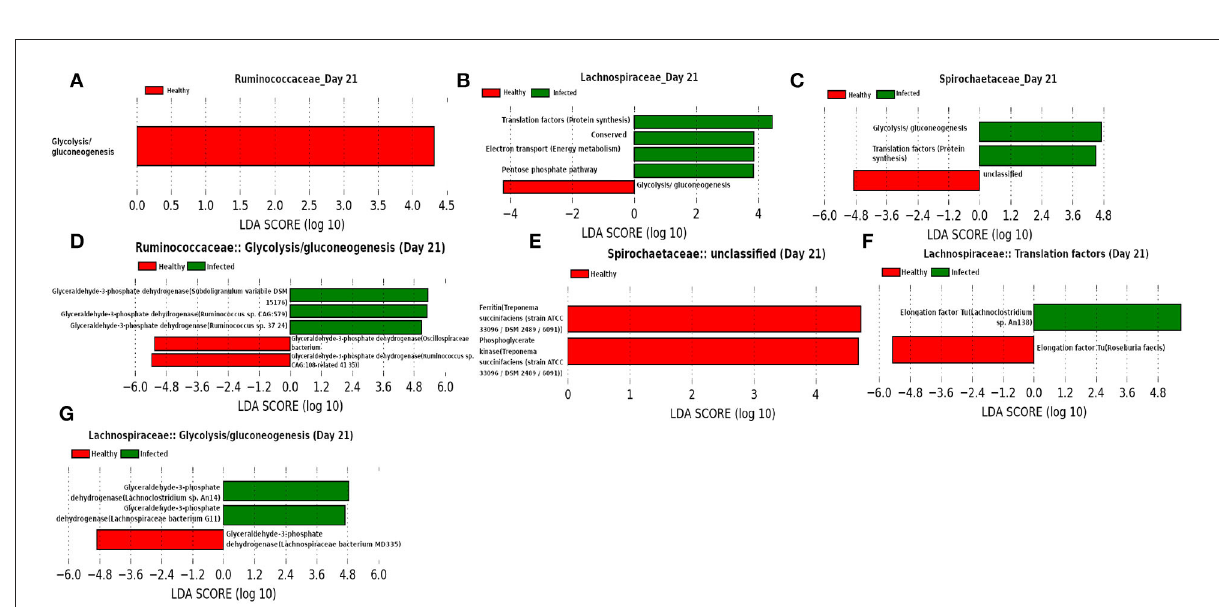
FIGURE14 (A–C) Linear discriminant analysis effect size (LEfSe) scores of the enriched functions of the dominant microbiome family, ASVs of which are found to be the member of infected-core-hub community or act as hubs or key-drivers in the infected cohort at day 21. (D–G) Linear discriminant analysis effect size (LEfSe) scores of the predicted biomarkers involved in the enriched microbial functions associated with healthy and infected cohorts at day 21.